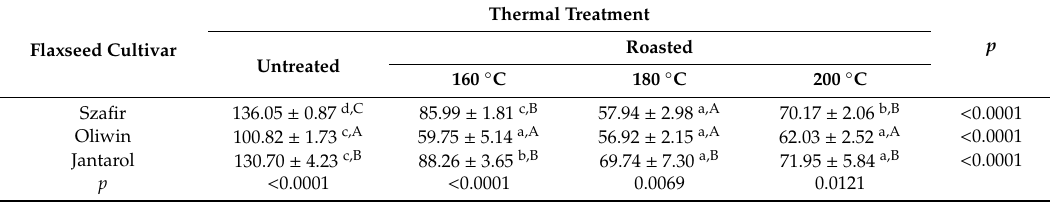
Table 3. The antiradical capacity of the untreated and roasted flaxseeds—ORAC_FL assay.